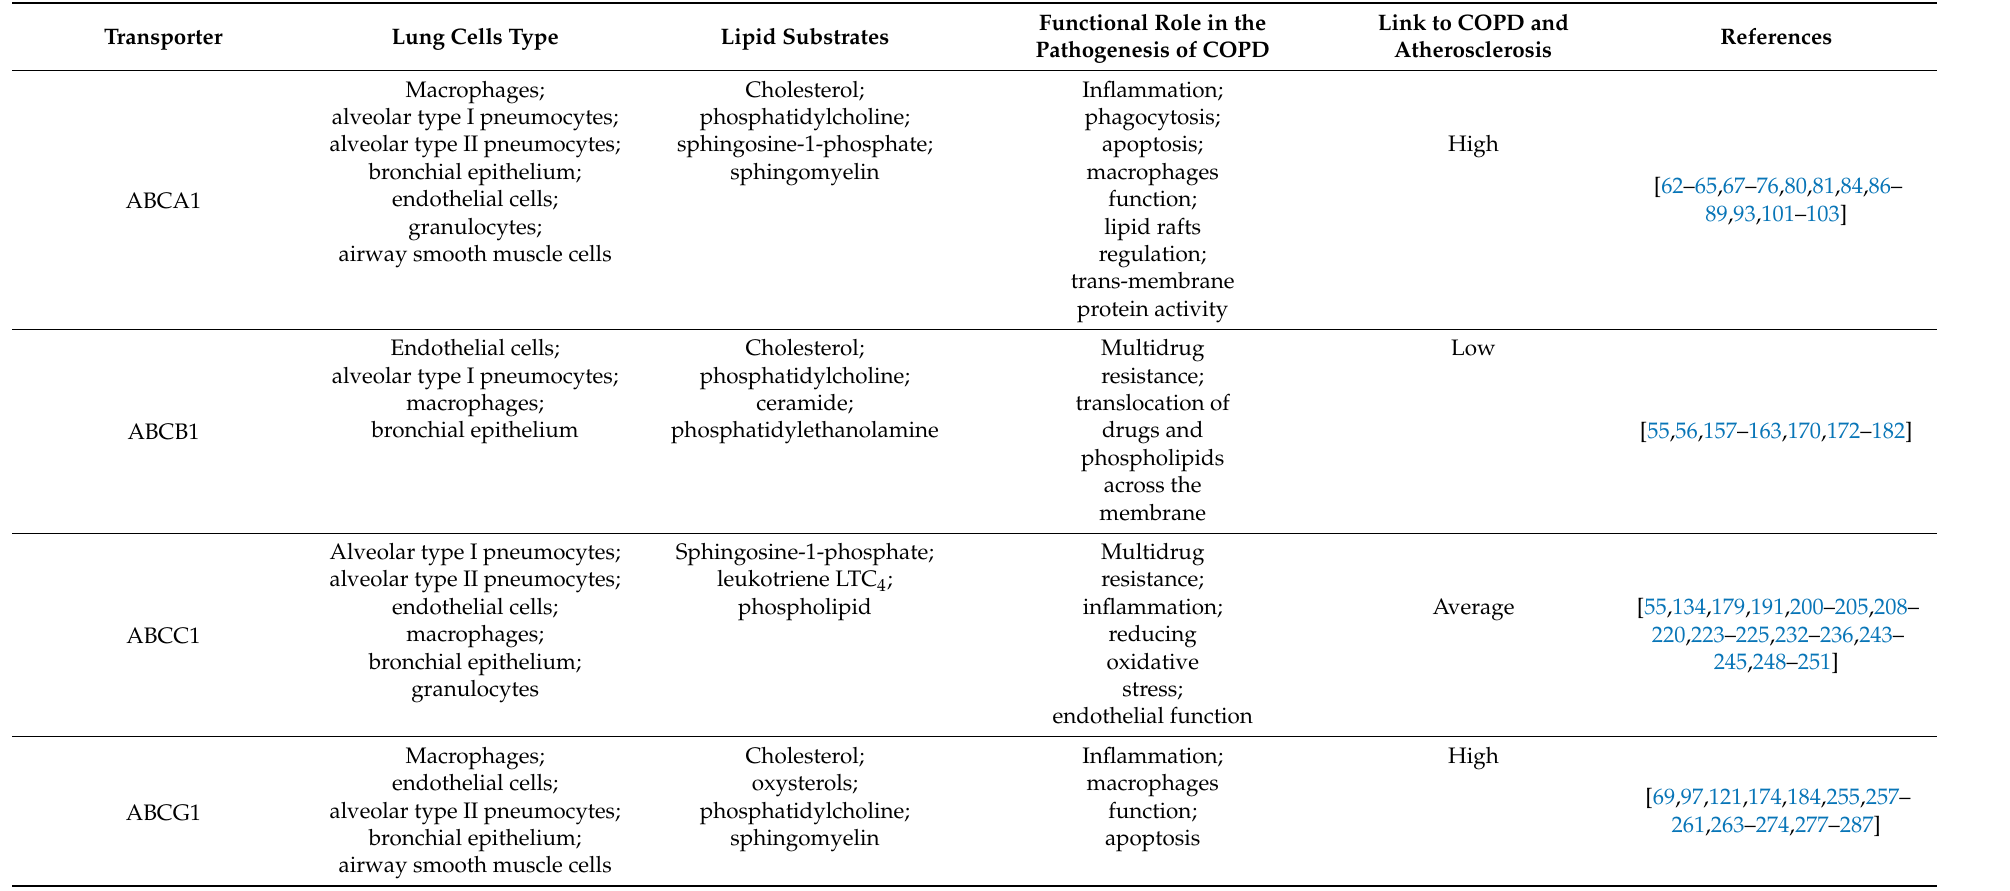
Table 1. Participation of key representatives of ABC transporters in lipid metabolism and the pathogenesis of